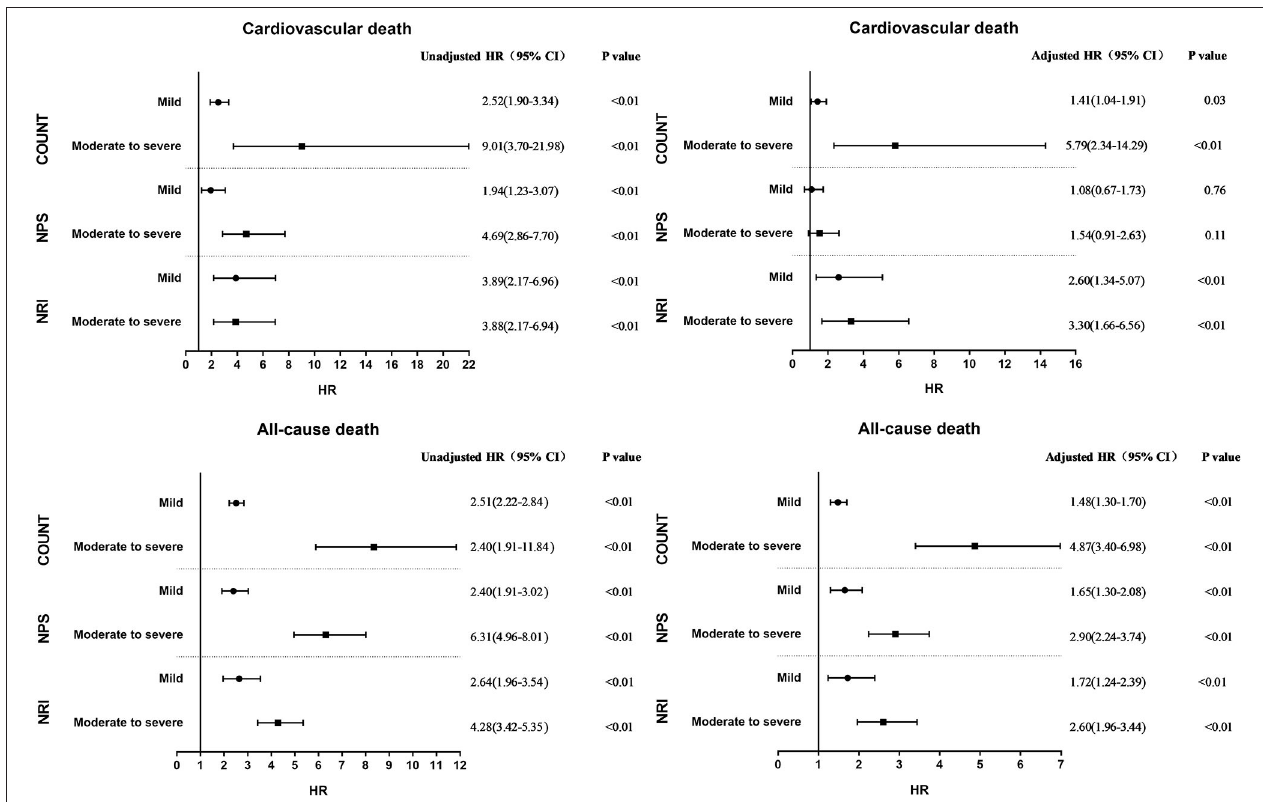
FIGURE 4 | Unadjusted and adjusted hazard ratio for cardiovascular death and all-cause death by degree of malnutrition according to the three nutritional screening